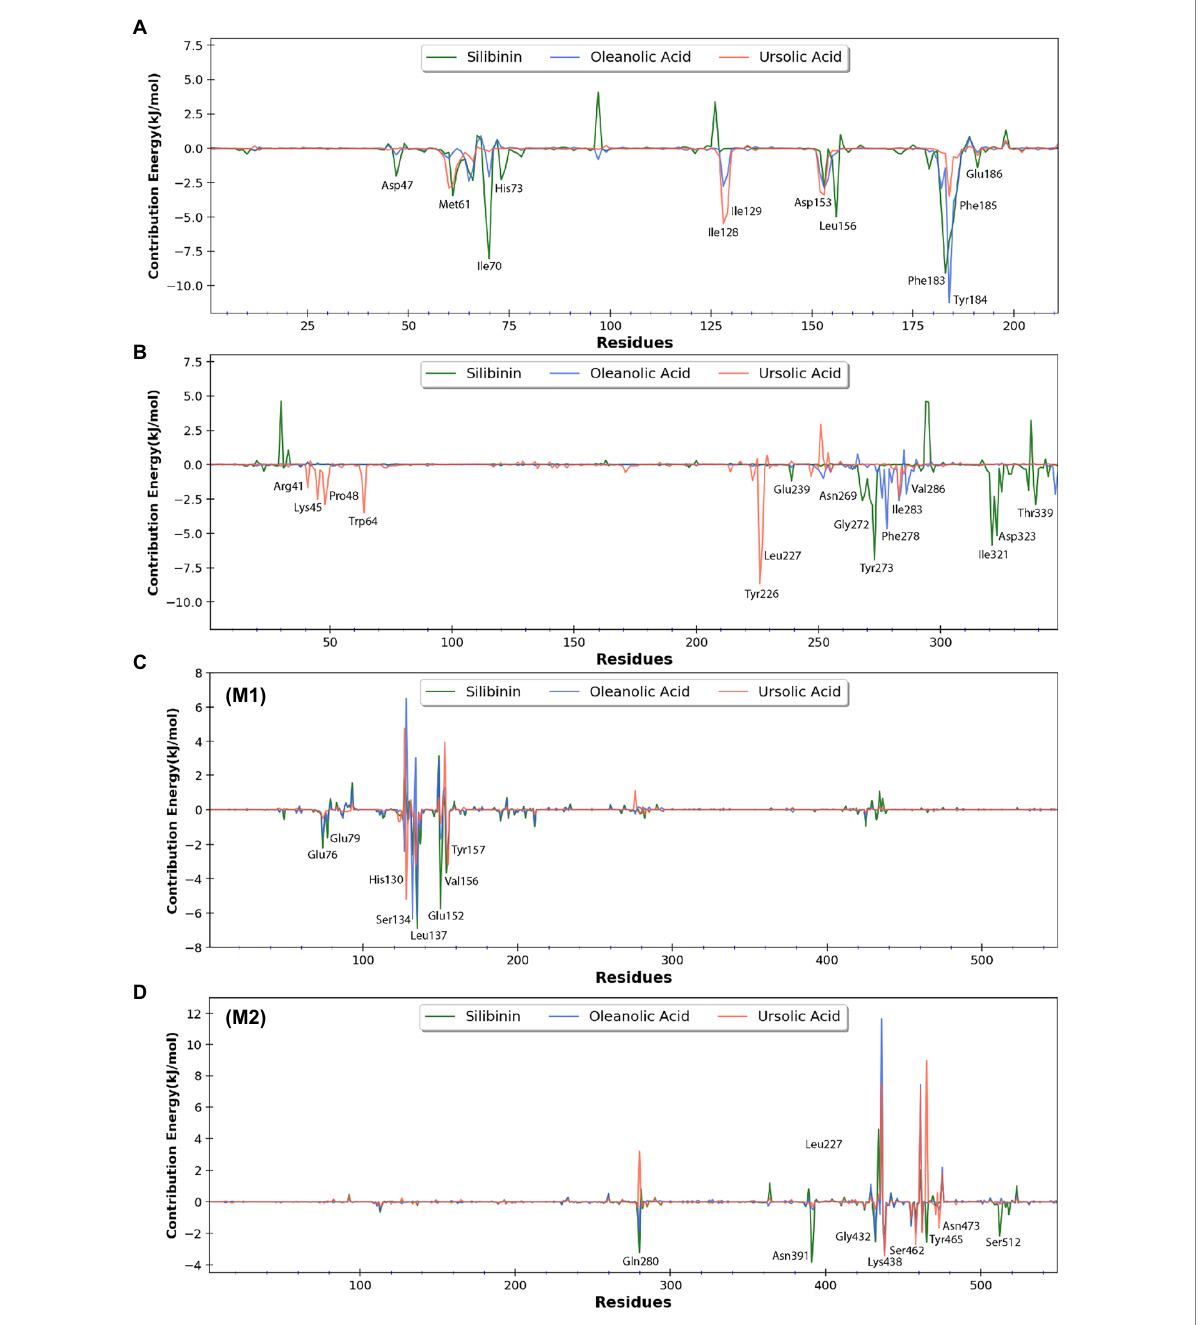
FIGURE 11 Free energy contribution of (A) H3 residues, (B) A26 residues, (C) D13 residues (monomer-1), and (D) D13 residues (monomer-2) interacting with the three selected phytomolecules. Major residues with negative free energy contribution are